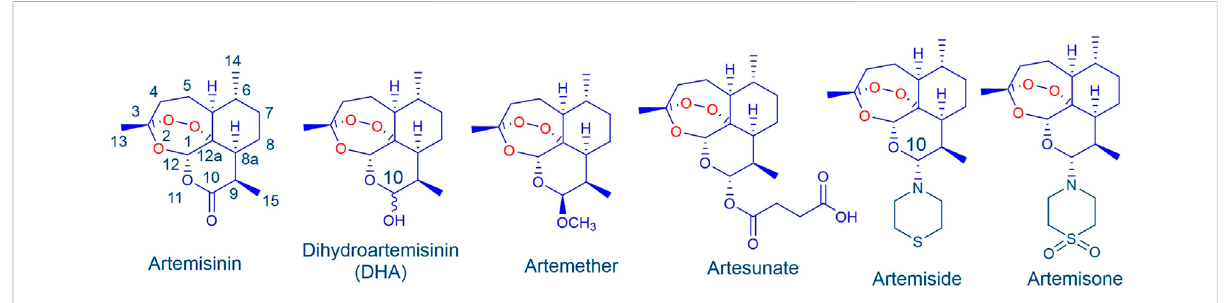
FIGURE 1 Artemisinin and clinical derivatives DHA, artemether and artesunate. The amino-artemisinins artemiside and artemisone possess a nitrogen atom attached to C-10 that enhances biological